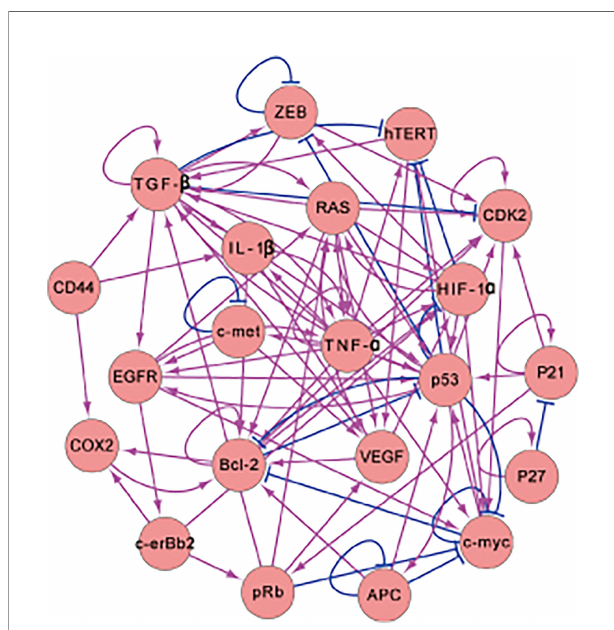
FIGURE 1 | The 17-node gene regulatory network for intestinal-gastric cancer. The network contains 17 genes and 82 regulations (There are 67 activating and 15 repressing regulators. The arrows and the blunted arrows denote the activating and repressing regulations,